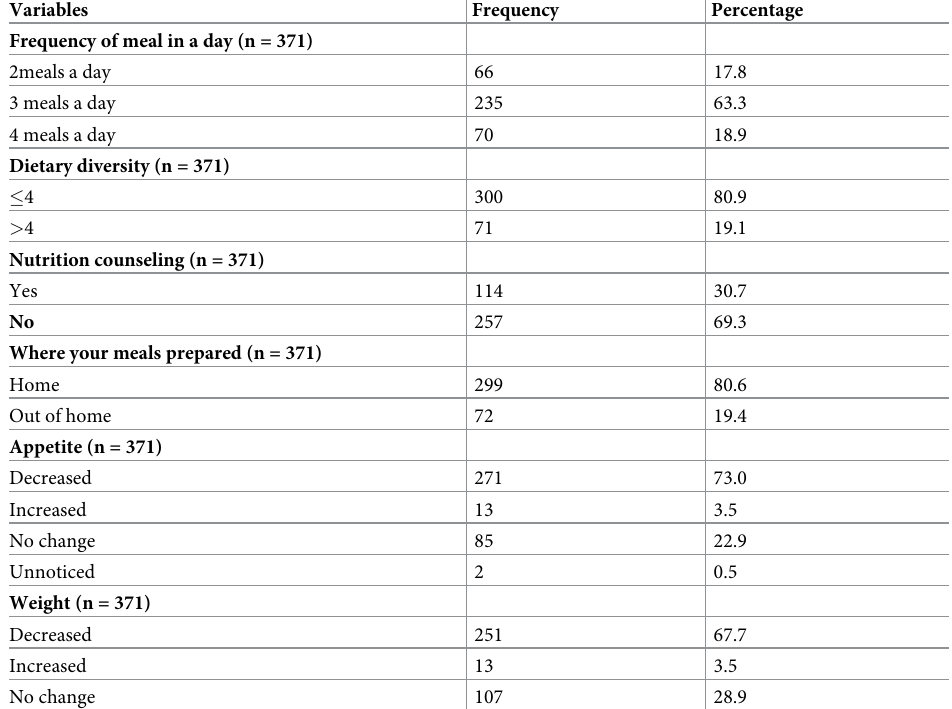
Table 3. Nutritional habits of chronic kidney disease patients in Saint Paulo’s and Zewditu Memorial Hospitals in Addis Ababa, Ethiopia, 2018. Variables Frequency Percentage Frequency of meal in a day (n =